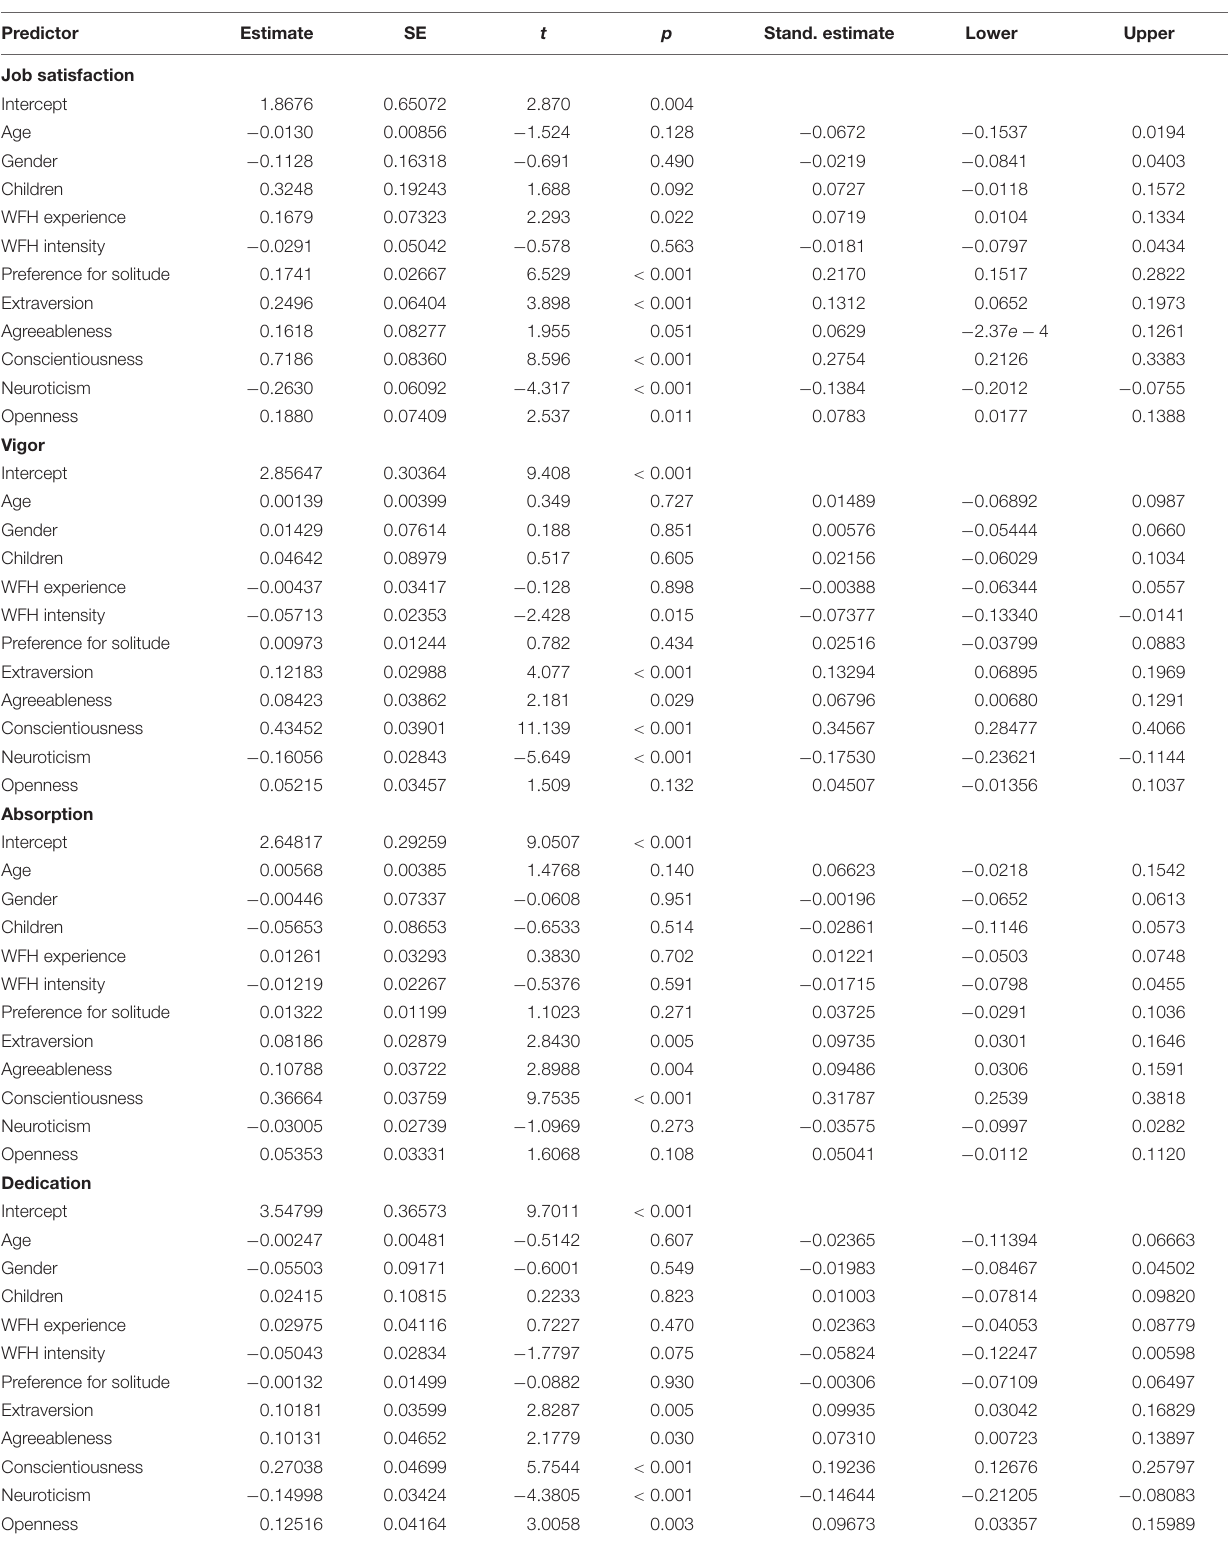
TABLE 3 | Hierarchical multiple regression analyses for measures of